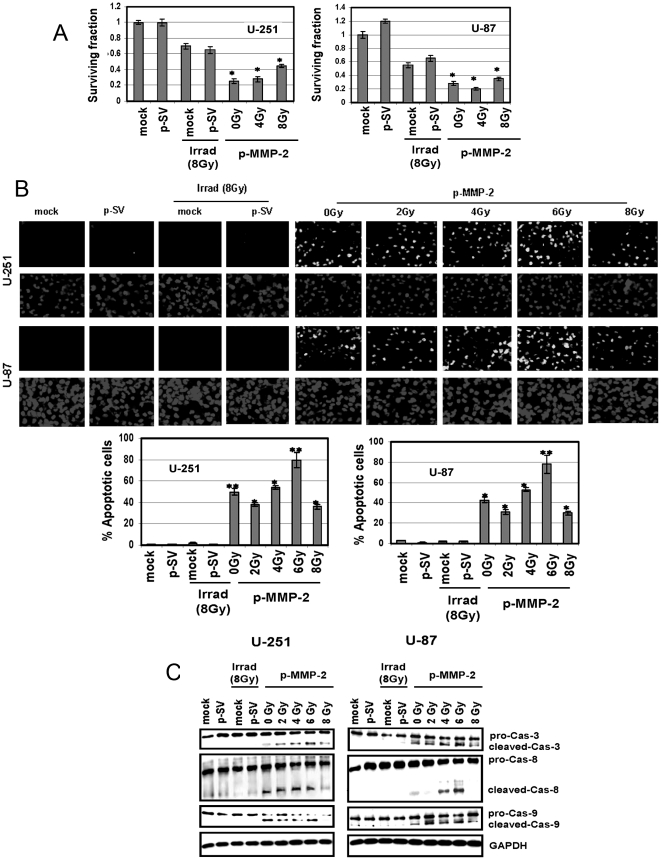
p-MMP-2 inhibits colony formation and induces apoptosis and activation of pro-apoptotic molecules in glioma cells.
A, Clonogenic assay was performed as described in Materials and Methods. The cells were cultured, and colonies larger than 50 cells were counted. Columns: mean of triplicate experiments; bars: SD; *p<0.01, significant difference from radiation. B, U-251 and U-87 cells were transfected with mock, p-SV or p-MMP-2, and irradiated as described earlier. After 24 h of radiation, cells were evaluated with the TUNEL assay according to manufacturer's instructions and photographed under fluorescent microscopy. Apoptosis was measured by counting the percentage of cells that showed DNA staining in five different fields in each group. Columns: mean of triplicate experiments; bars: SD; *p<0.01, **p<0.001, significant difference from mock, p-SV or irradiated controls. C, Equal amounts of protein from whole cell lysates of control and treated cells were analyzed by Western blotting using caspase-specific primary antibodies. GAPDH served as a loading control.